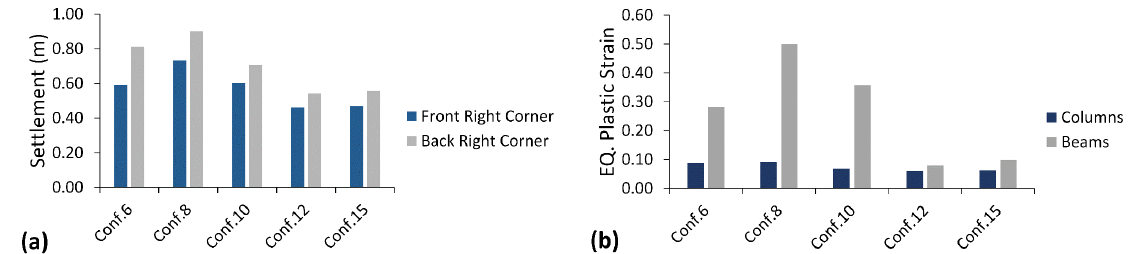
Figure 13. Seismic performance of different infill panels in configurations under the Nahanni earth ‐ quake: ( a ) settlement at the top of the structure and ( b ) maximum equivalent plastic strain .